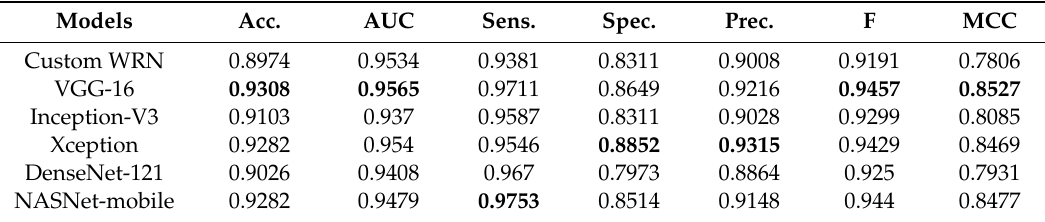
Table 5. Performance achieved by the deep learning (DL) models in classifying the pediatric CXR dataset (baseline) into bacterial and viral categories. Here, Acc.: accuracy, Sens.: sensitivity, Prec.: precision, F: F-score, and MCC: Matthews correlation coe ffi cient.